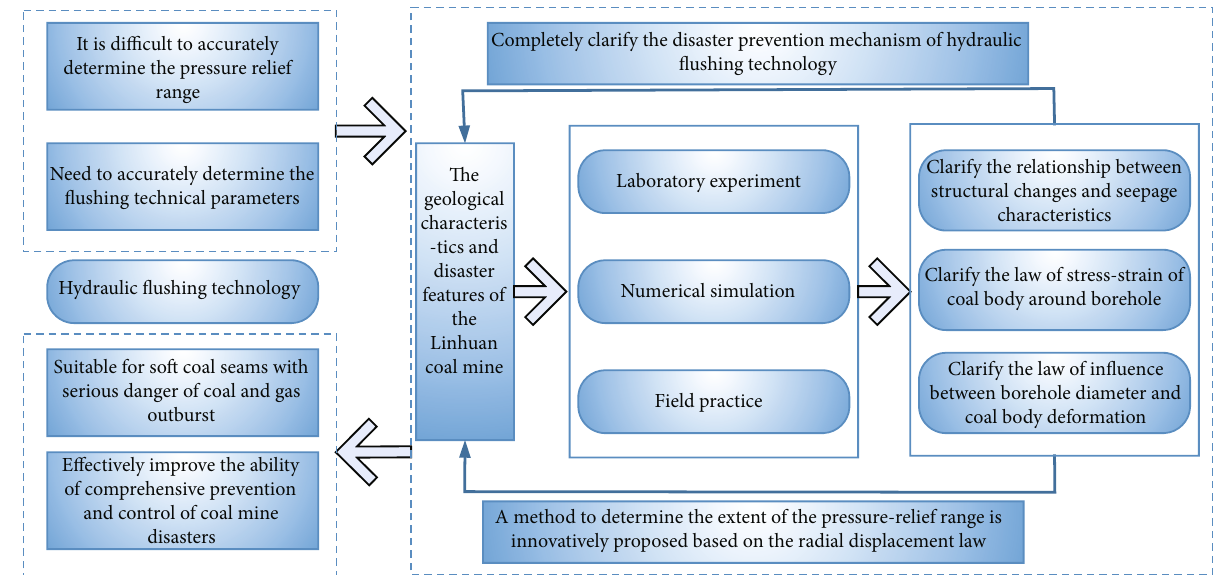
Figure 1: The general sketch of the problem under